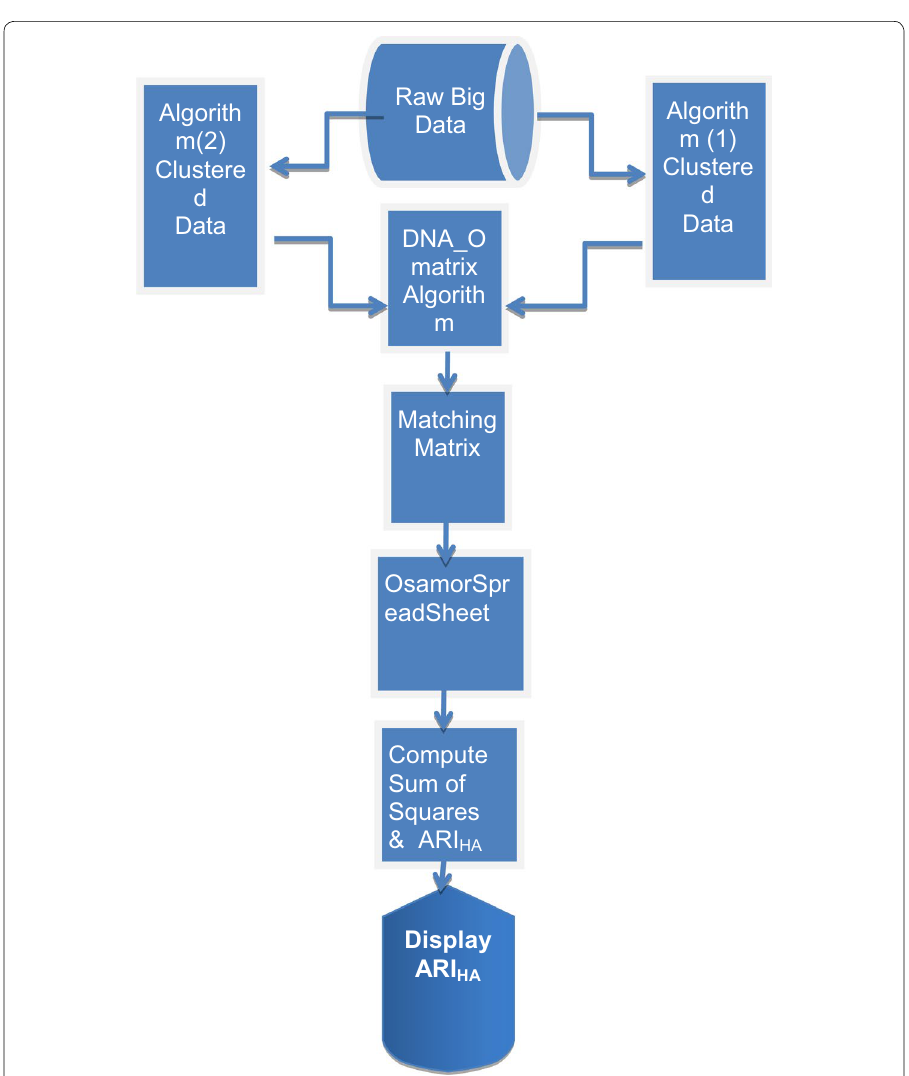
Fig. 1 The proposed pipeline allows raw big data access into both Algorithm 1 and 2 whose cluster partitions is intended to be evaluated. The DNA_O Matrix Java program accepts (see Fig. 2a, b), these clustered partitions separately and processes it to generate a Matching matrix that serves as input into OsamorSpreadsheet for computation of model statististics and AHI HA . Based on the computed values of the statistics, a decision is taken by the system to conclude one choice out of the 4 defined level of evaluation of similarity ranging from value of 0–1 as specified in Table